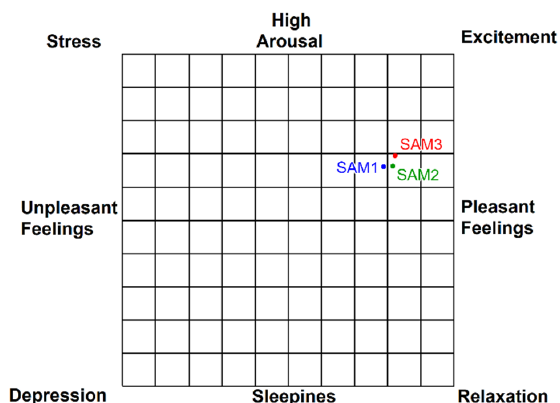
Figure 12. Representation of the mean arousal and valence scores using the Affect Grid.